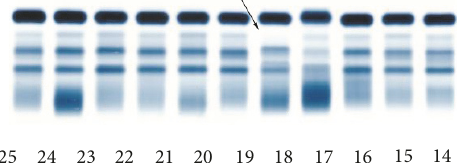
Figure 1: Serum protein electrophoresis investigation with reduced alpha 1 globulin band (arrow, column 18).